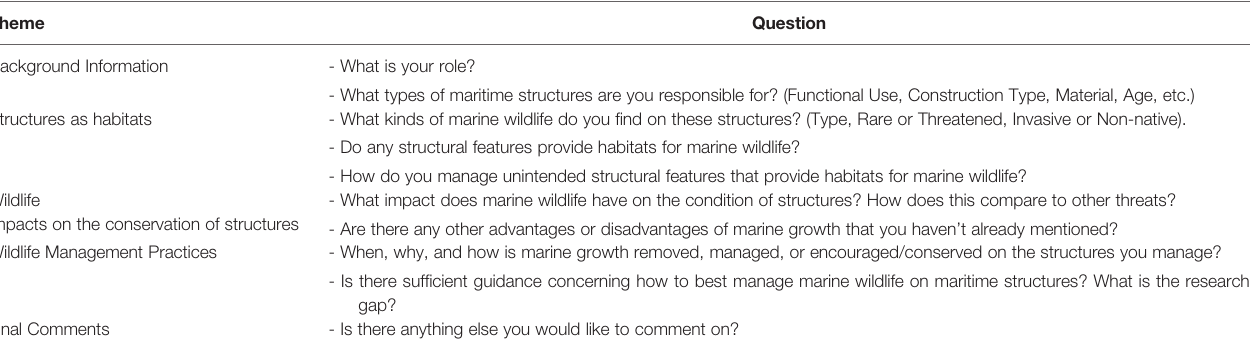
TABLE 3 | Interview questions.